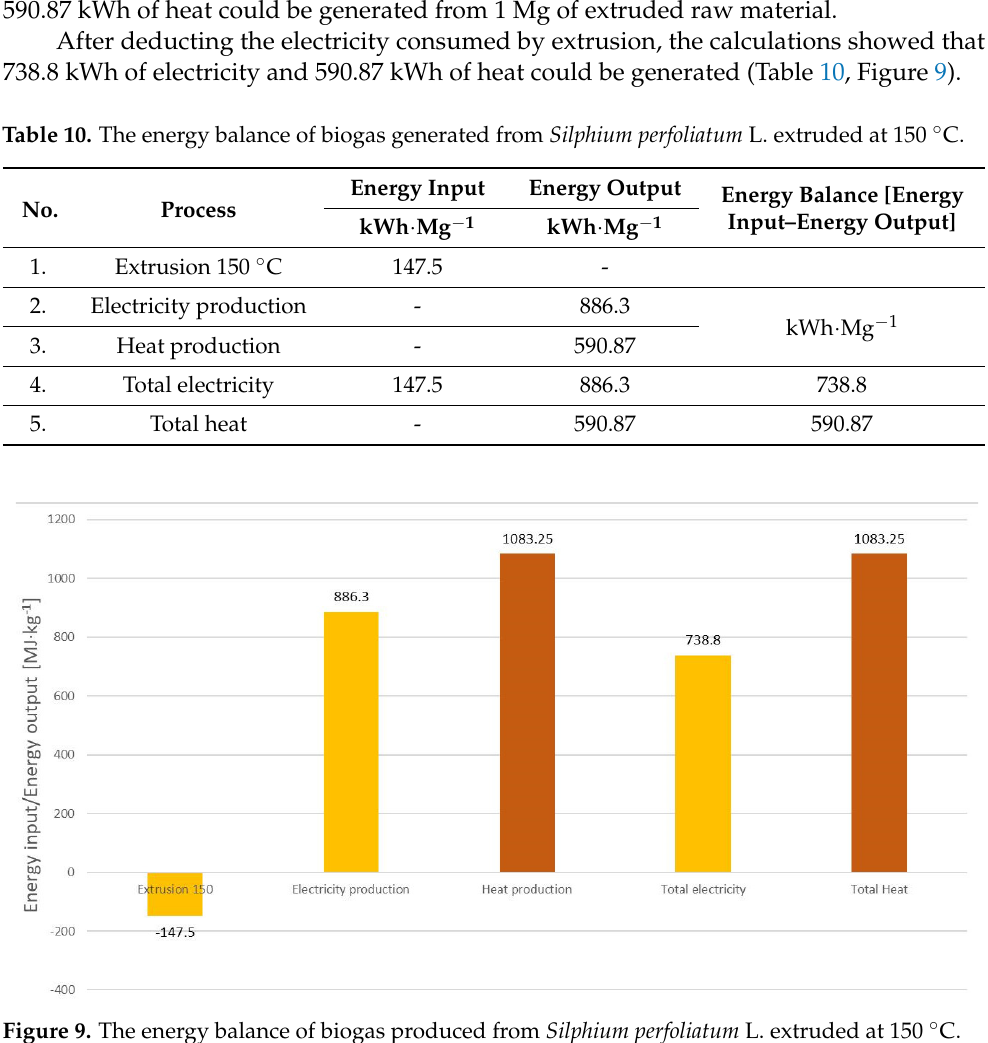
Table 11. The energy balance of biogas generated from Silphium perfoliatum L. extruded at 175 °C.